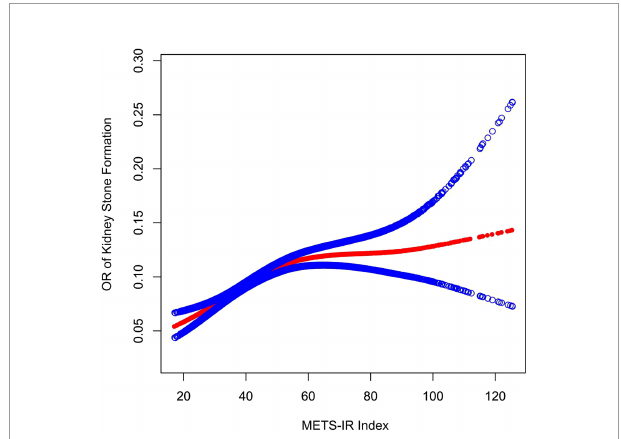
FIGURE 2 | Density dose – response relationship between METS-IR index with kidney stone formation. The area between two blue dotted lined is expressed as a 95% CI. Each point shows the magnitude of the METS-IR index and is connected to form a continuous line. Adjusted for all covariates except effect modi fi